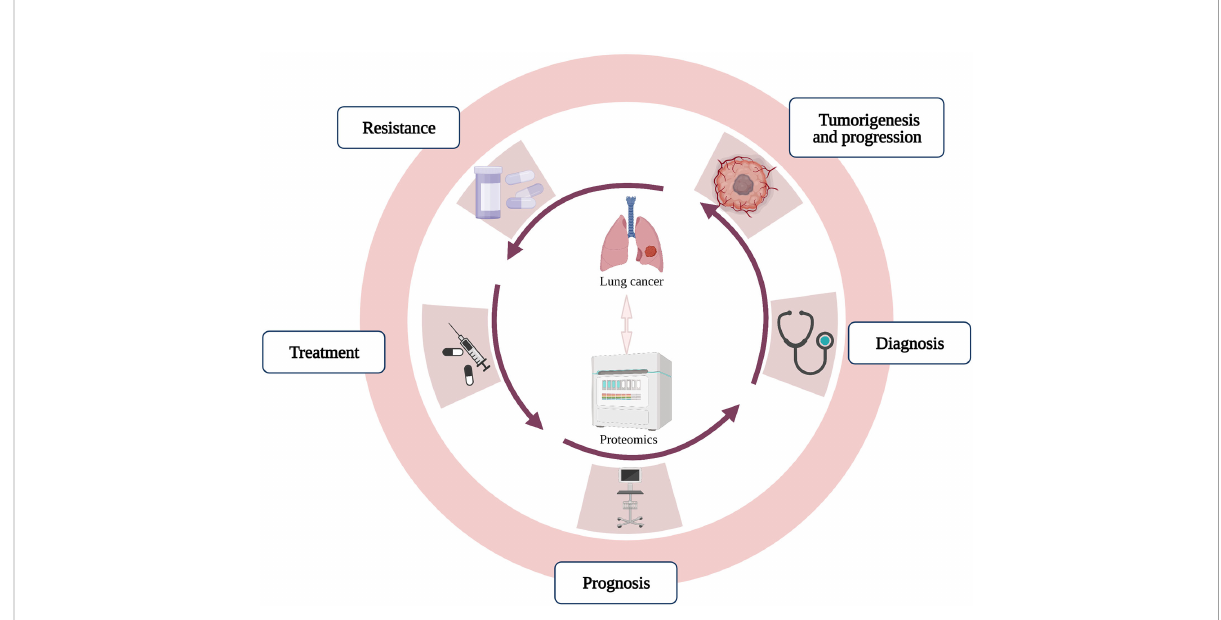
FIGURE 1 The application of proteomics in lung